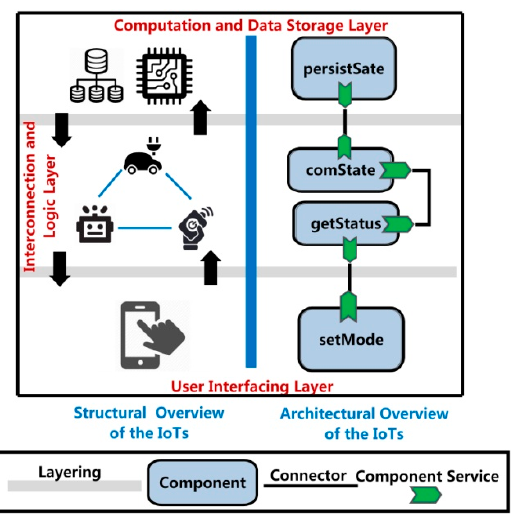
Figure 2. Overview of Software Architecture for Internet of Thing (IoT) based Systems.